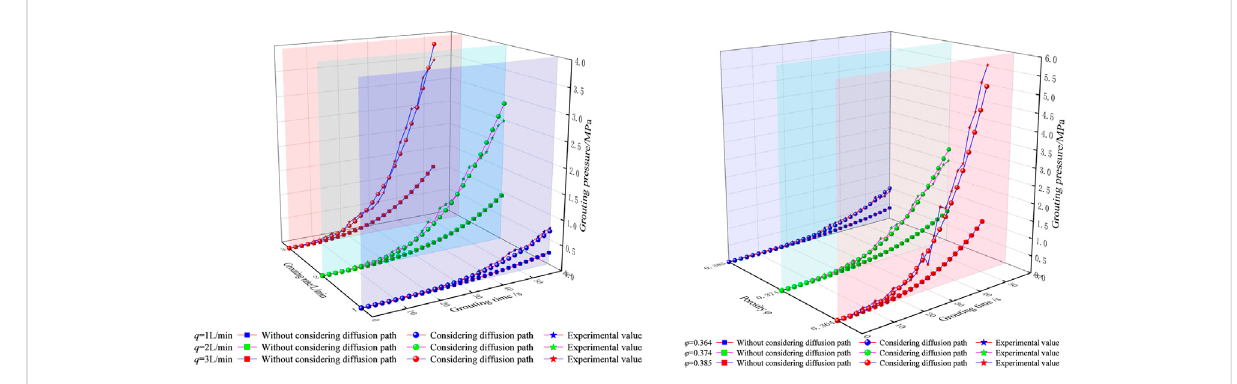
FIGURE 6 Variation curve of grouting pressure with